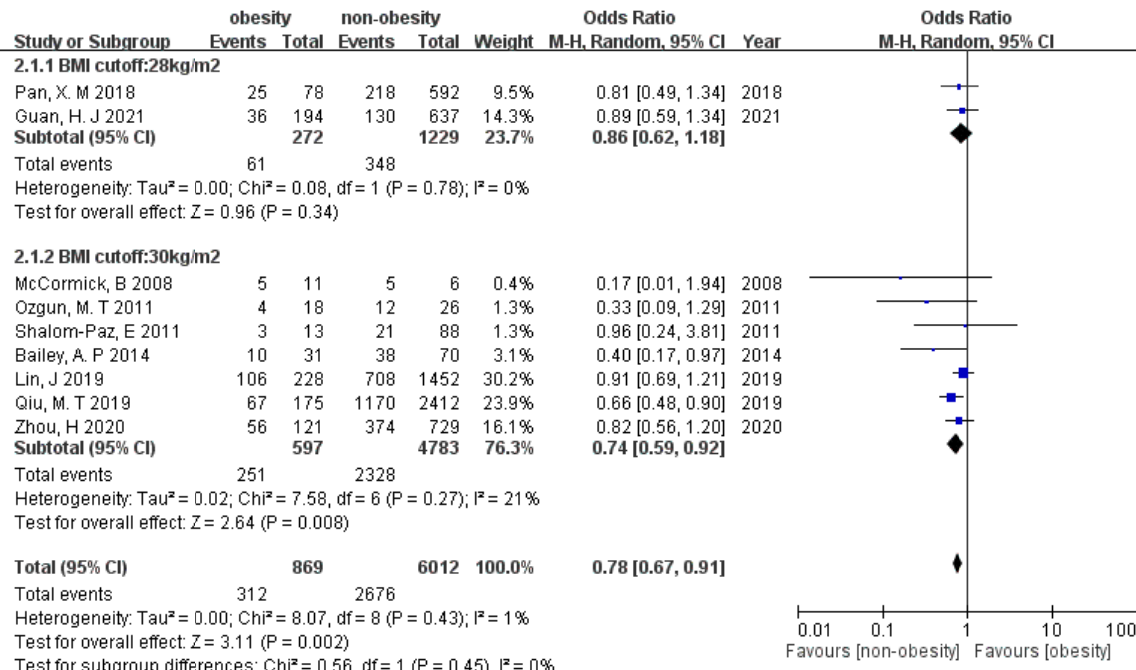
Figure 4. Forest plot of the association between live birth and overweightness in women with PCOS.